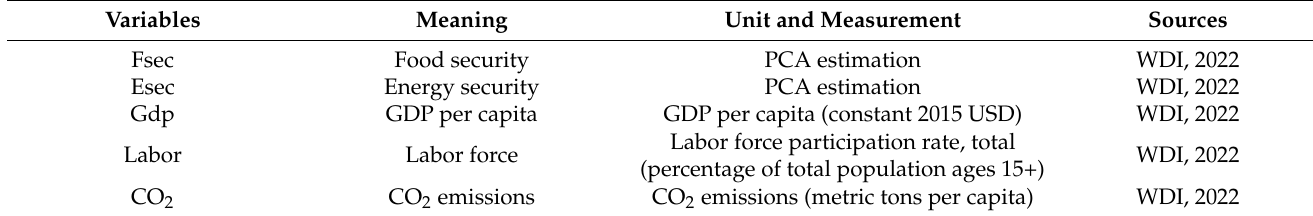
Table 1. Variables measurement and